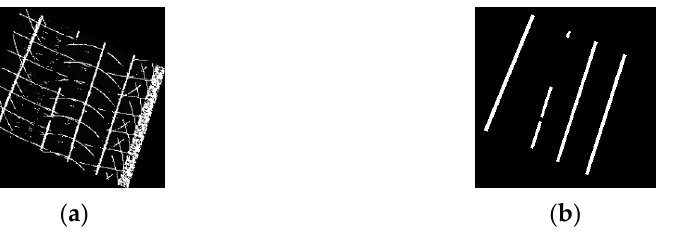
Figure 14. Training data: ( a ) input intensity image and ( b ) corresponding